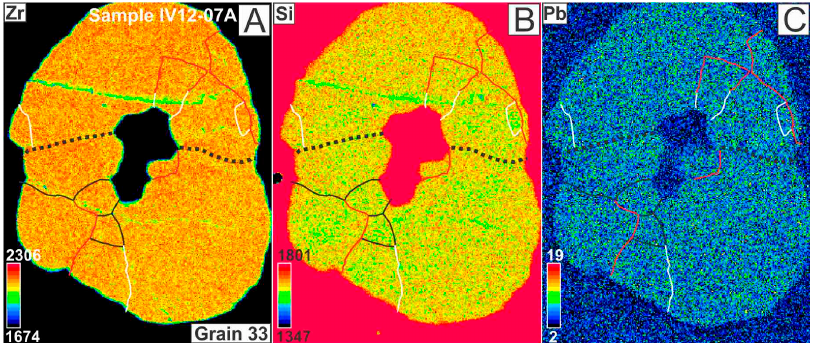
Figure 3. Additional chemical maps of the grain 33, sample IV12-07A. ( A ) Qualitative chemical map of Zr distribution. ( B ) Qualitative chemical map of Si distribution. ( C ) Qualitative chemical map of Pb distribution. Color-coding indicates the number of counts, different for each map. Lines as in Figure 2.